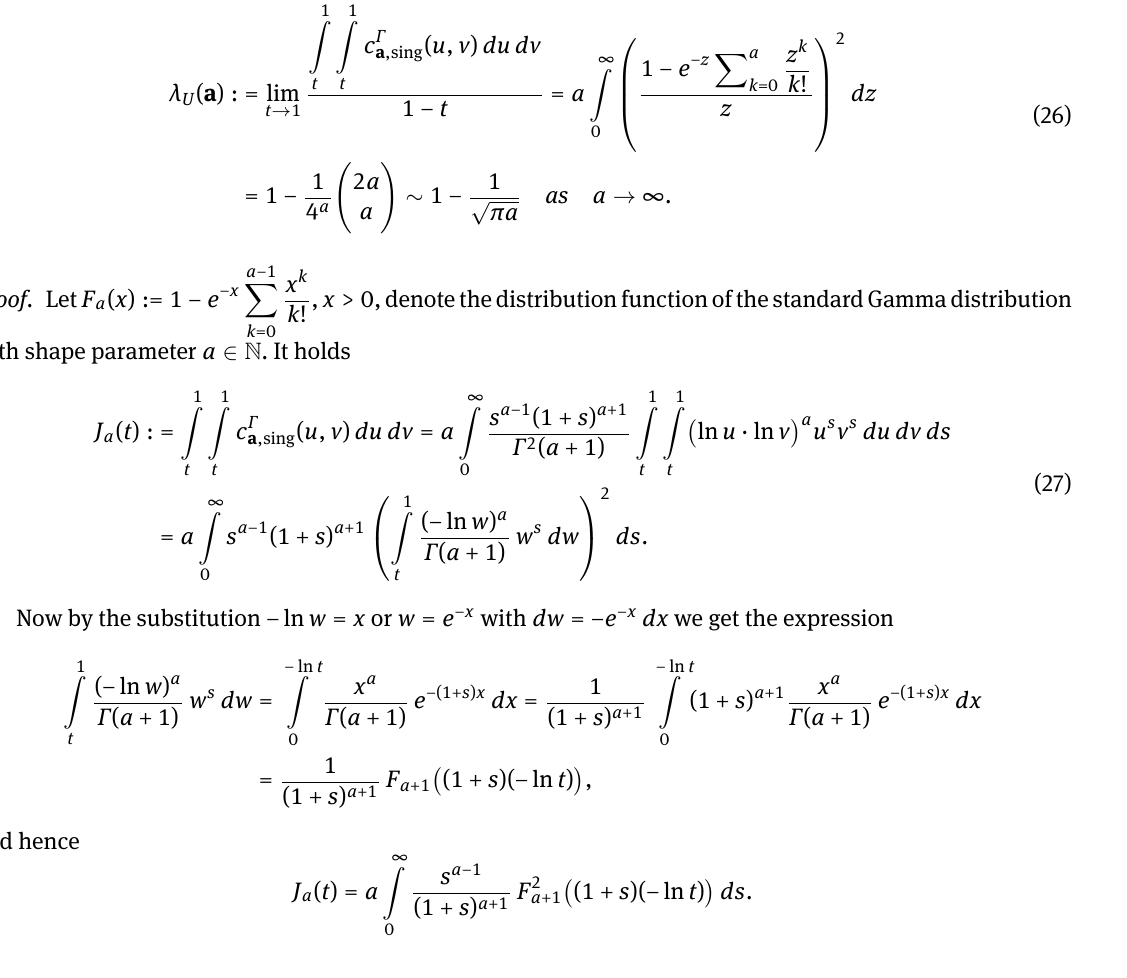
c NB a ,sing ( u , v ) , a = 7 Figure 7: Ratio Figure 6: Ratio c Γ a ,sing ( u , v )